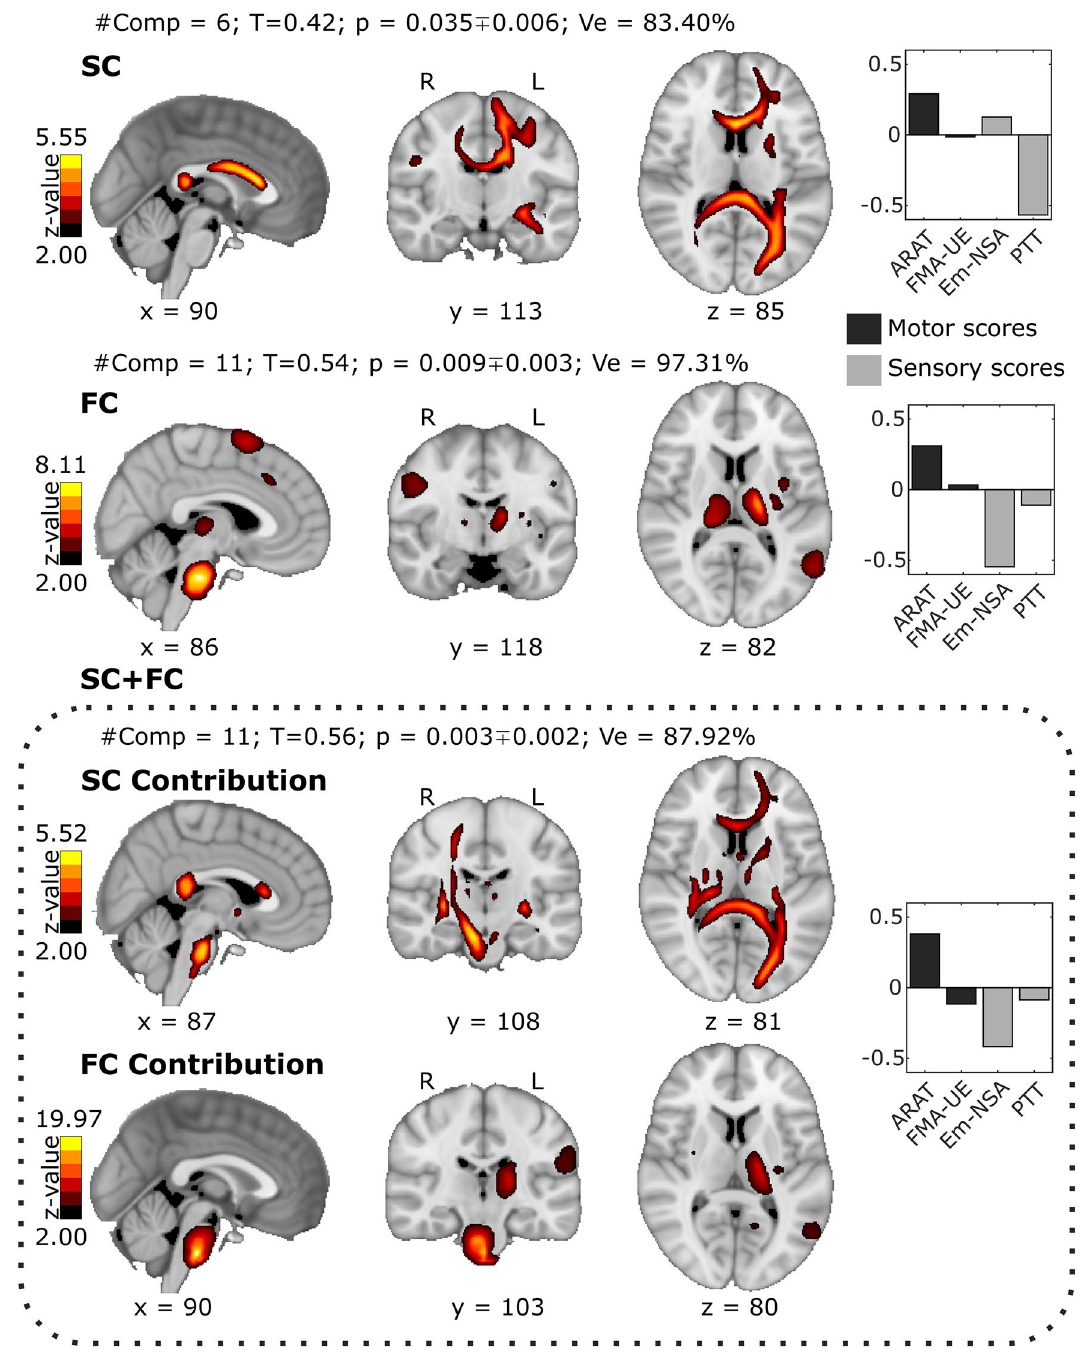
Figure 4. Brain maps with a maximal behavioral association from the unimodal and multimodal Lesion Network Mapping and CCA. Final maps of the CCA solution that provide the maximum correlation between the X variables (the PCA components from each modality) and the Y variables (a combination of several behavioral scores represented in Fig. 2). From top to bottom, SC brain maps (accounting for SC disconnectivity), FC brain maps, and SC + FC multimodal maps (box with dashed line). Moreover, the bottom panel also shows the individual SC and FC contributions to the maximum performance achieved by the multimodal SC + FC strategy. Together with the maximum behavioral-association maps, in all cases we provide the number of PCA components used (#Comp), the maximum correlation value (T), p-value (p) with the error intervals, and the amount of variance explained (Ve). For visualization, all maps were threshold to Z > 2 , but complete maps with no thersholding are given in Fig. S5. In the left panel of each row we represent the behavioral weights corresponding to the maximum behavioral-association